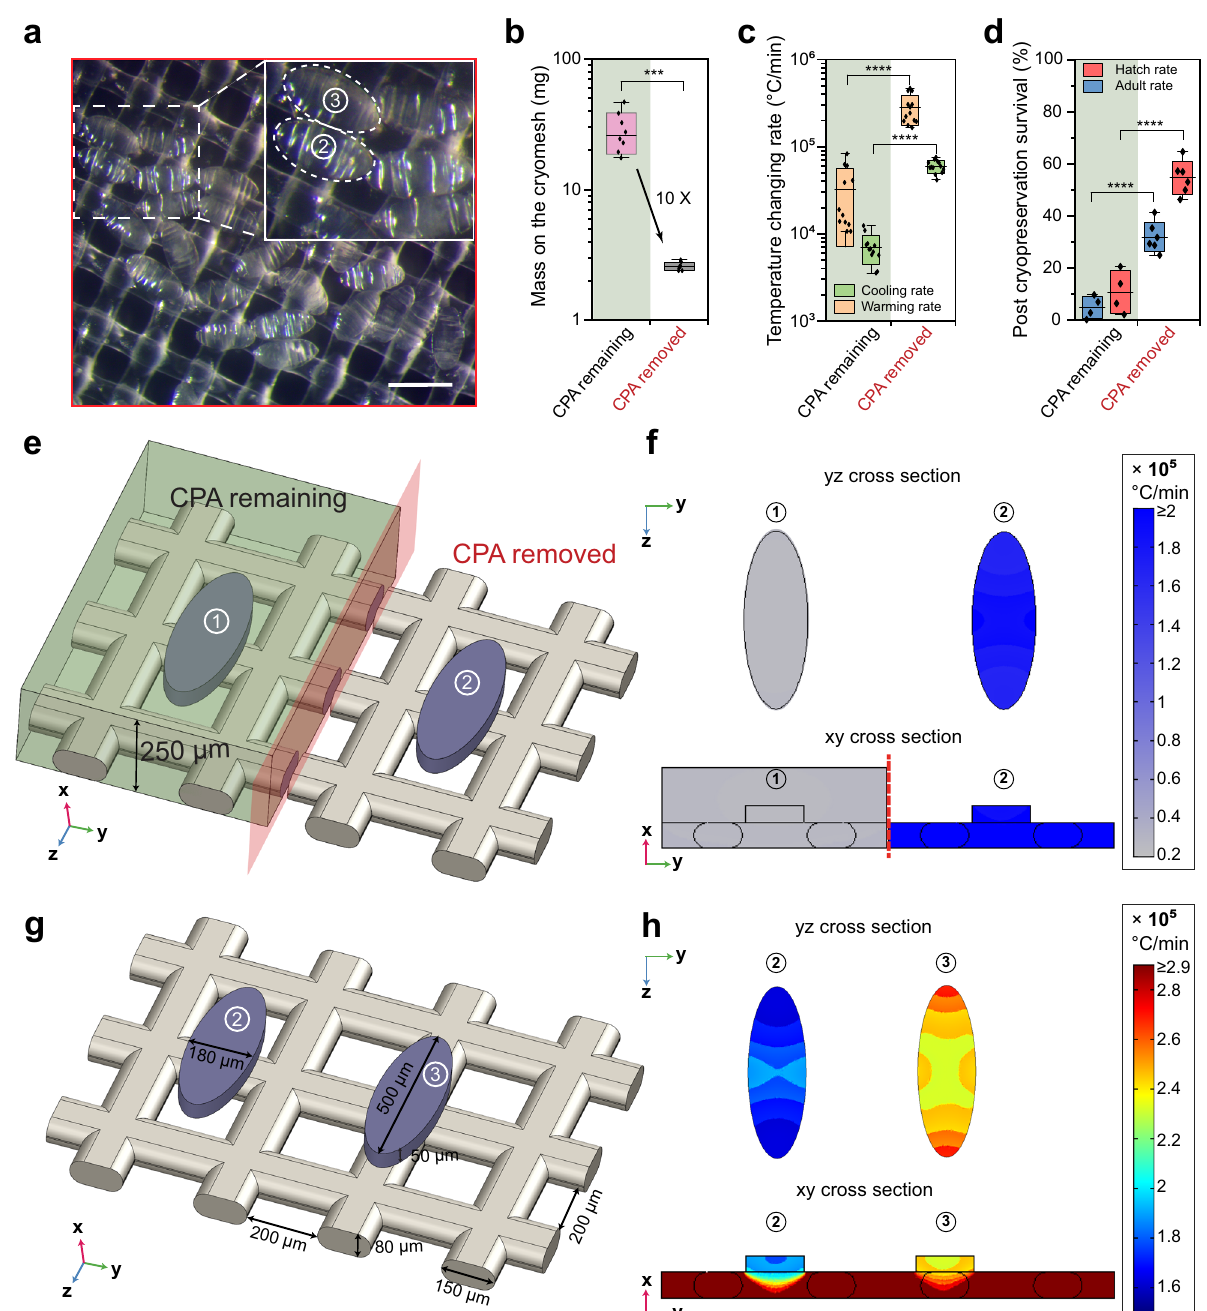
Fig. 3 Cooling and warming rate using the cryomesh. a Image of embryos on the cryomesh with CPA removed. Inset is the embryo with minimal (embryo 2) or maximal (embryo 3) contact with the cryomesh (outlined in white). Five experiments were repeated independently with similar results. b After the embryos were collected, the weight on the cryomesh was measured with CPA removed or remaining. c Measured cooling and warming rate of the embryos on the cryomesh. d Post cryopreservation survival with CPA removed or remaining on the cryomesh. e Warming rate modeling for the comparison of CPA remaining (embryo 1) or removed (embryo 2) on the cryomesh. f Simulated warming rates at different cross-sections through the center point of embryo 1 and embryo 2. g With CPA removed, warming rate modeling for embryo with minimal (embryo 2) or maximal (embryo 3) contact with the cryomesh. h Warming rates at different cross-sections through the center point of embryo 2 and embryo 3. In ( f ) & ( h ), color scales represent the simulated warming rates. Scale bar is 500 μ m. Box and horizontal line represent standard deviation and mean respectively; whiskers represent max and min. n = 8 for ( b ); n = 12 for ( c ); n = 4 or 6 for ( d ); n stands for independent replicates. In ( d ), 1695 embryos were pooled over n = 6 independent replicates; 1433 embryos were pooled over n = 4 independent replicates. Two-sided multivariate analysis of variance (MANOVA) and Tukey ’ s post hoc were used for statistical analysis. *** p ≤ 0.001; **** p ≤